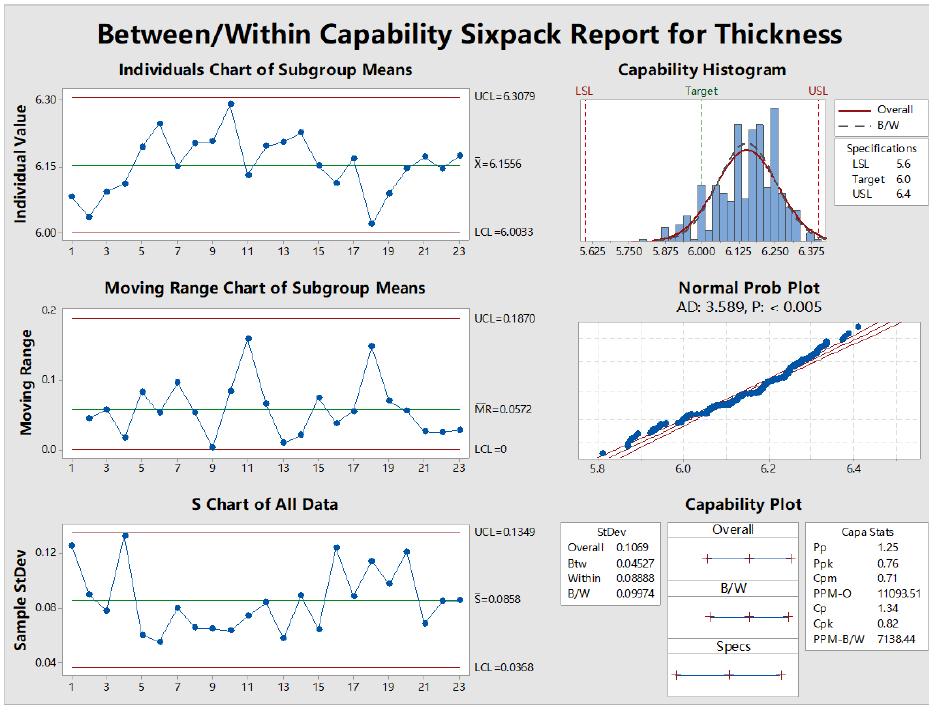
Figure 5. Thickness Between/Within Capability Sixpack for the 23 lots.